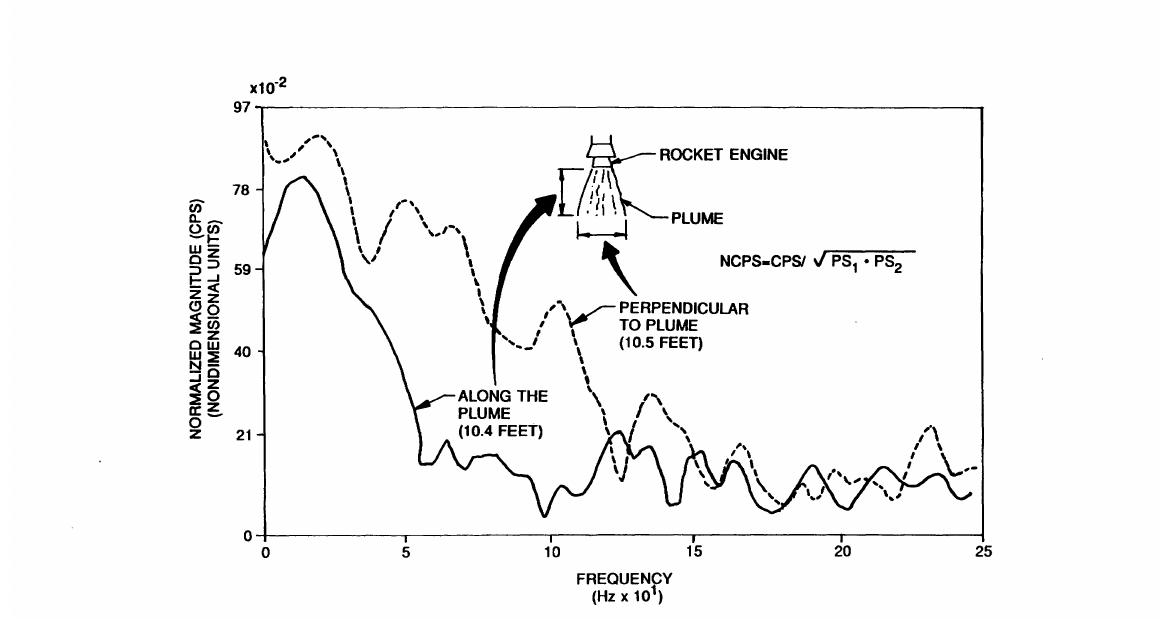
FIGURE 4 Variation of normalized cross-power spectrum along the rocket plume